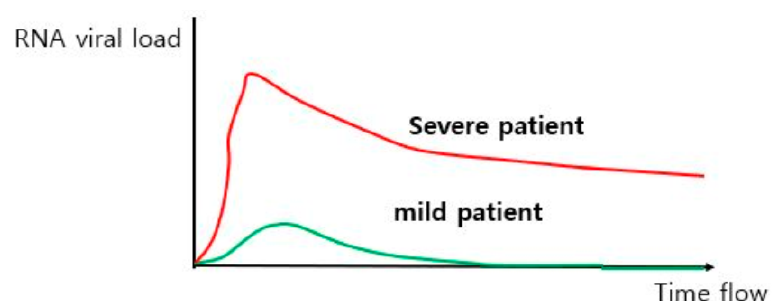
Figure 4. Difference in viral load between mild and severe COVID-19 patients. The viral load seen in COVID-19 patients was positively correlated with symptom severity, greater mortality, and longer recovery time. In particular, viral load in severe or critical patients showed two features compared to mild patients: higher peak viral load and delayed viral clearance.